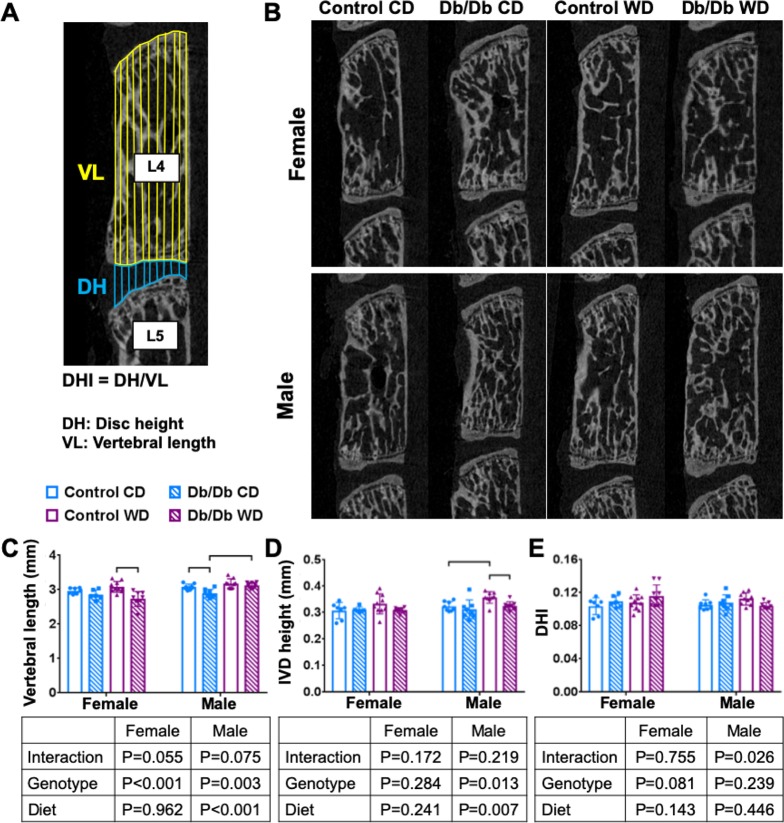
Leptin receptor deficiency caused decrease vertebral length and disc height, but no change in disc height index.A) Schematic of IVD height and vertebrae length measurement. B) μCT midsagittal sections of vertebral bone for (top) female and (bottom) male. p < 0.05. C) vertebral length D) IVD height E) DHI.